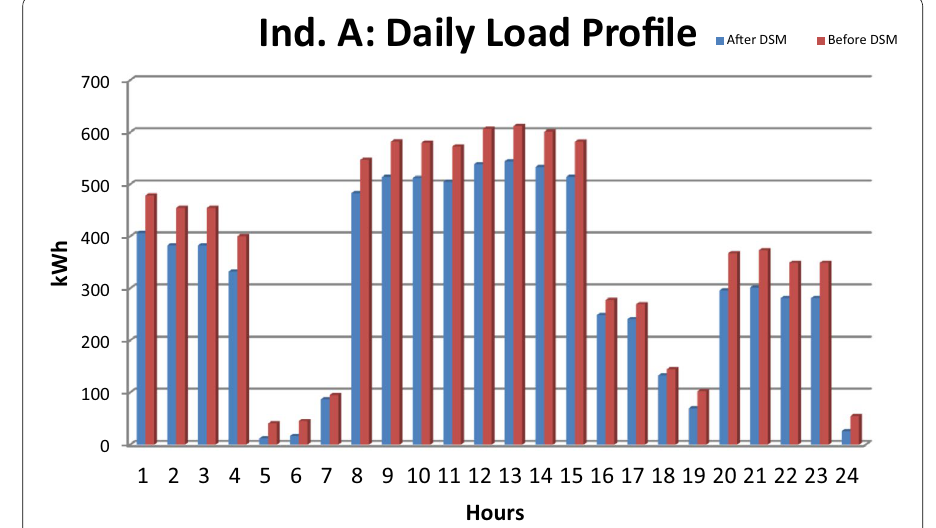
Fig. 5 Load profile for industry A before and after the DSM solution